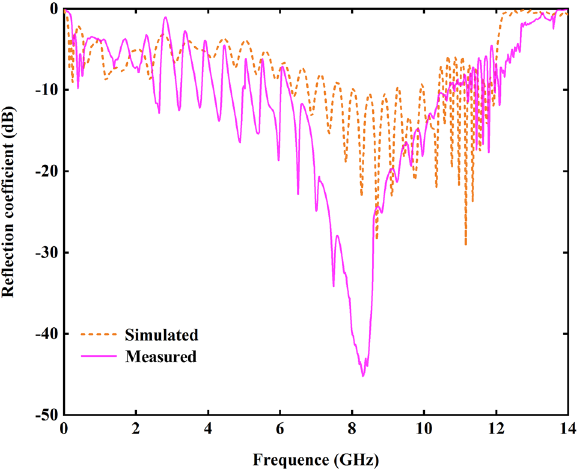
Figure 3. Impedance characteristics of high-order OAM mode single-port loop antenna.